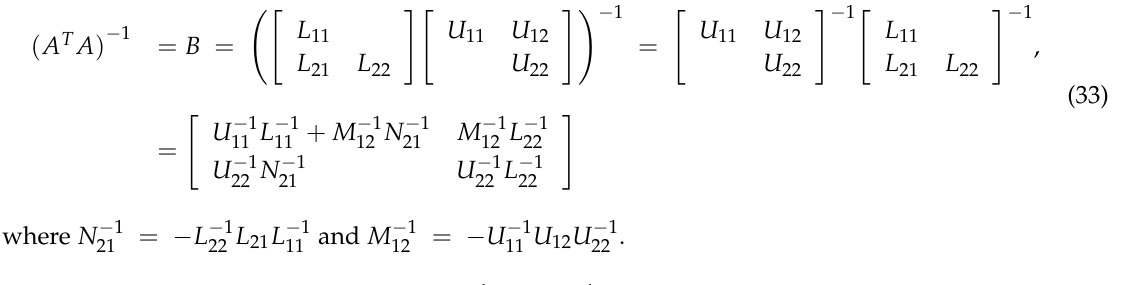
N − . ( b ) The architecture of 1 . ( b ) The architecture of M − 1 21 21